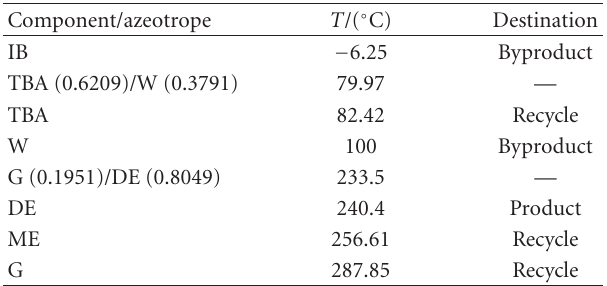
Table 2: Boiling point for pure components and azeotropes at P = 1